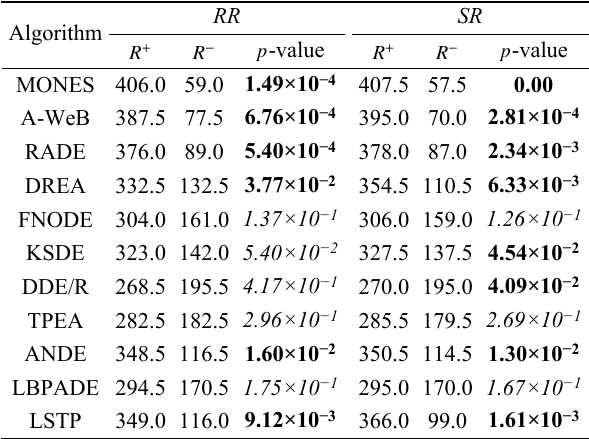
Note: R + is the rank sum for the functions in which our algorithm is superior to other algorithms, R − is the sum of ranks for the opposite, and p -value is to judge whether the two methods are significantly